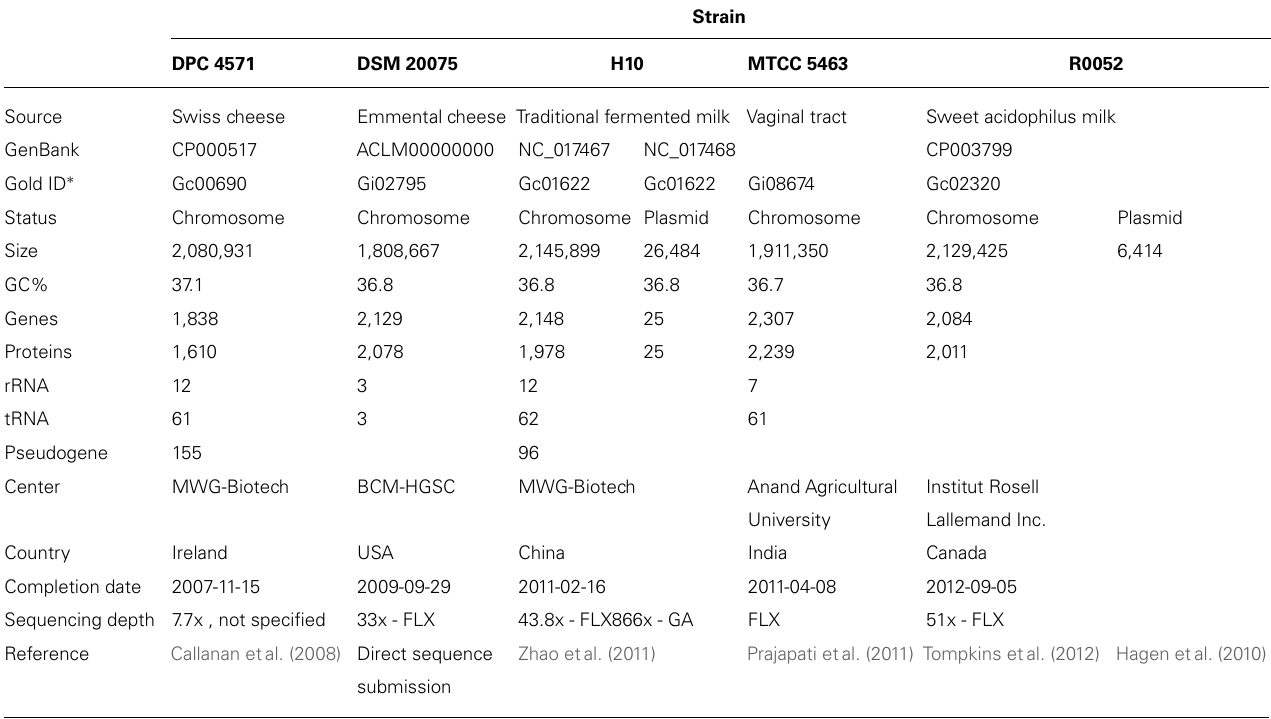
Table 1 | Genome features of the five Lactobacillus helveticus strains (DPC 4571, DSM 20075, H10, MTCC 5463, and R0052) sequenced to completion.